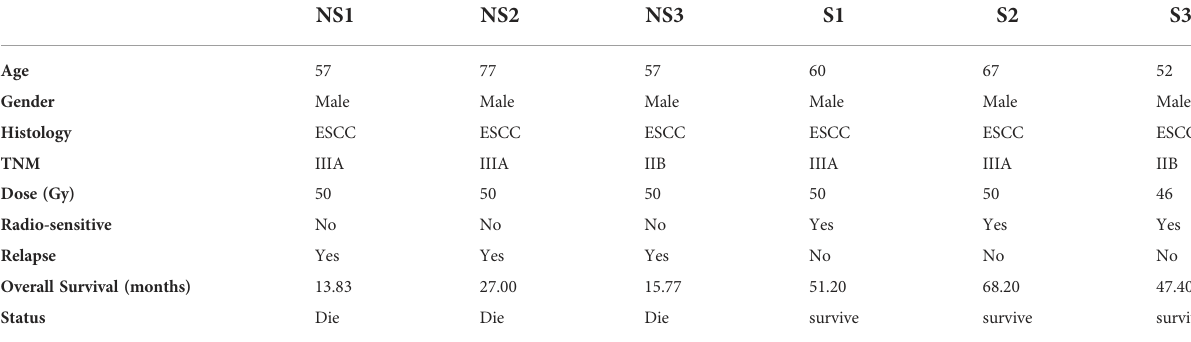
TABLE 1 Clinicopathologic characteristics of ESCC patients who received